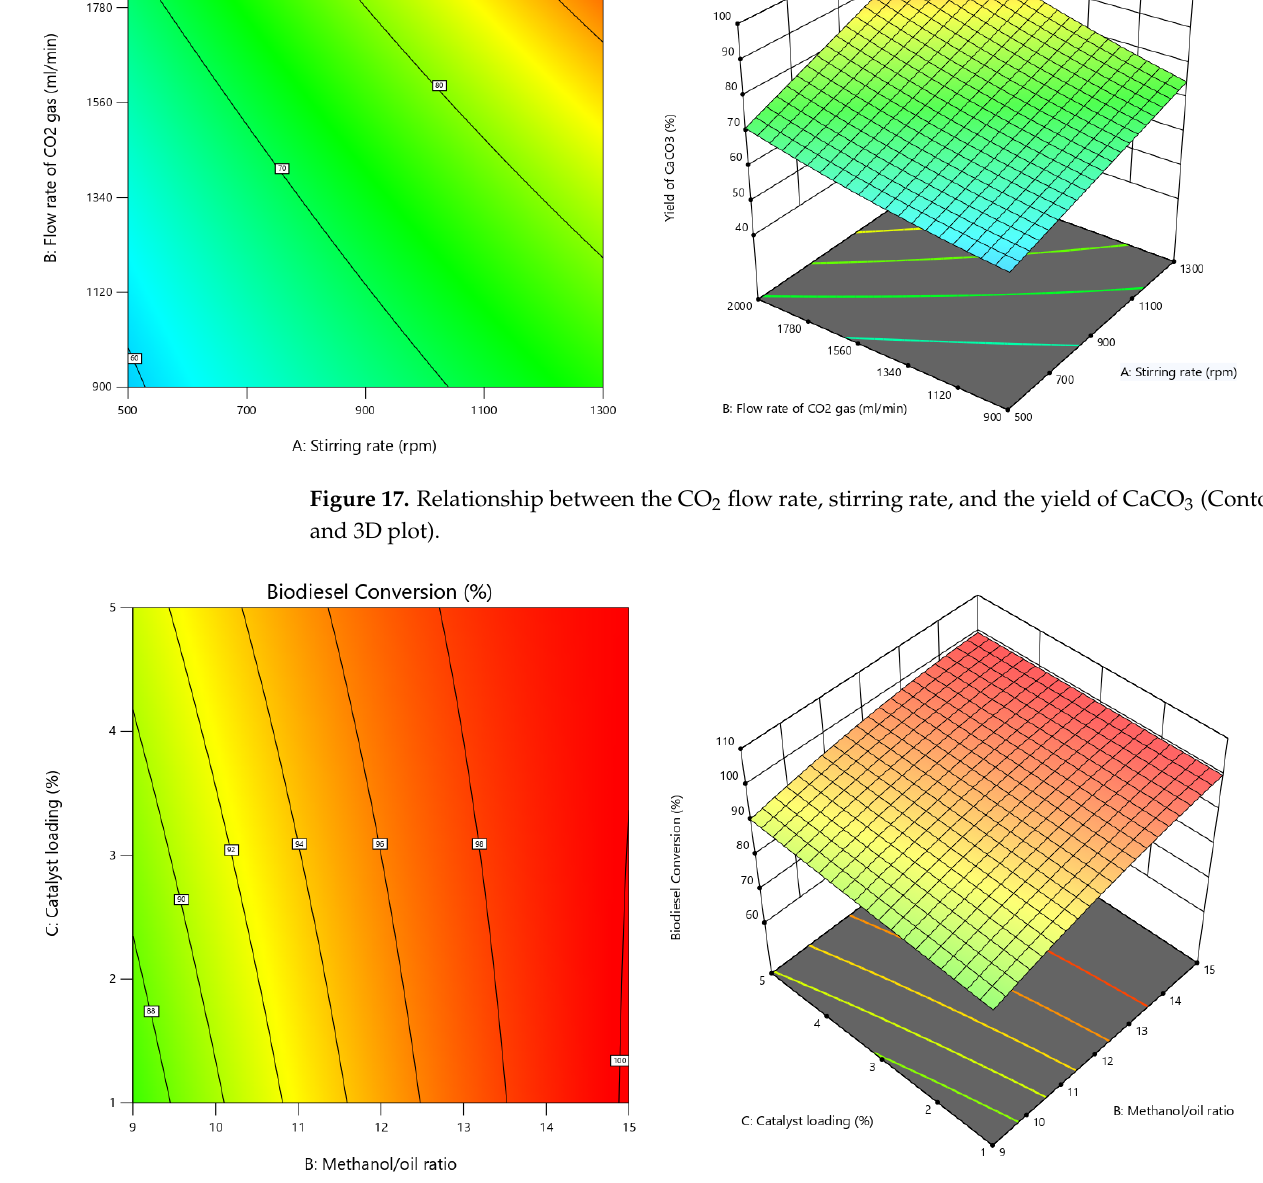
Figure 18. Relationship between the catalyst loading, methanol to oil ratio, and the yield of biodiesel (Contour and 3D plot).